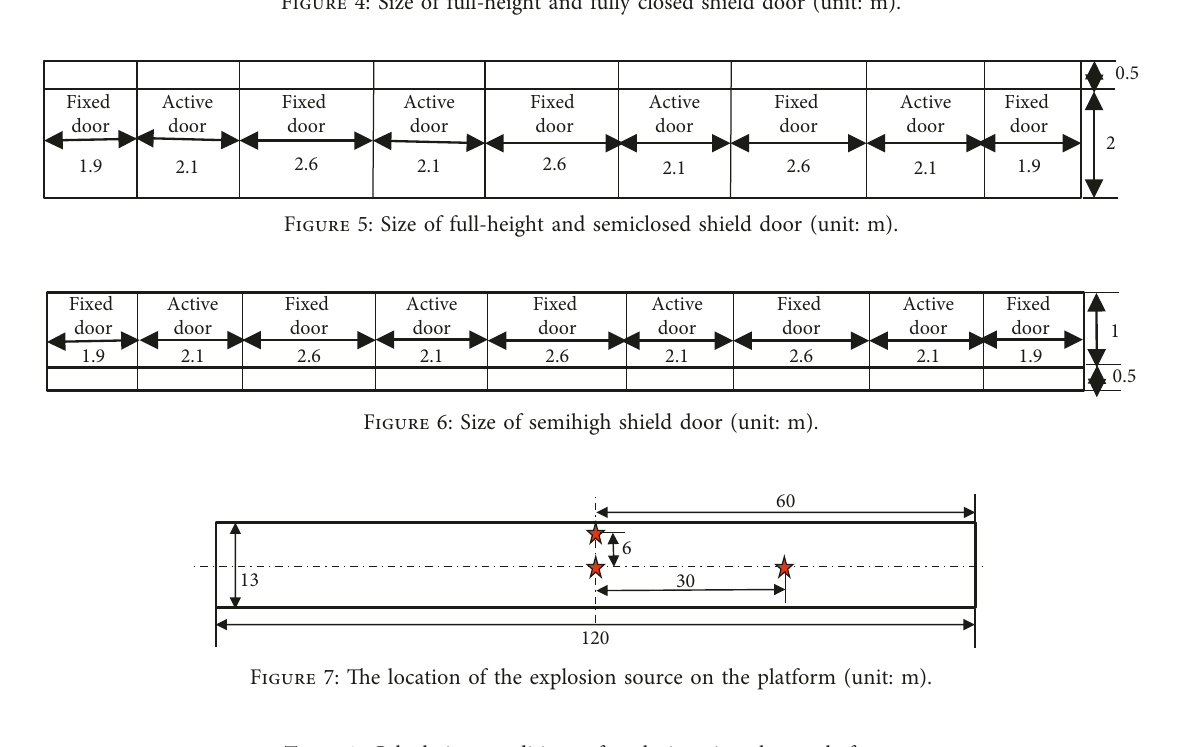
Figure 4: Size of full-height and fully closed shield door (unit: m).